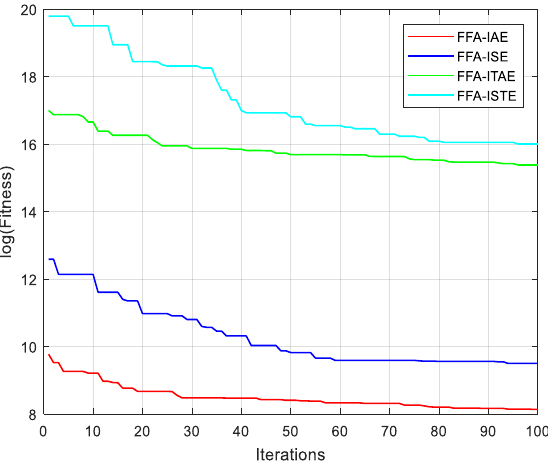
Figure 11. Convergence curves for different criteria with FFA algorithms.